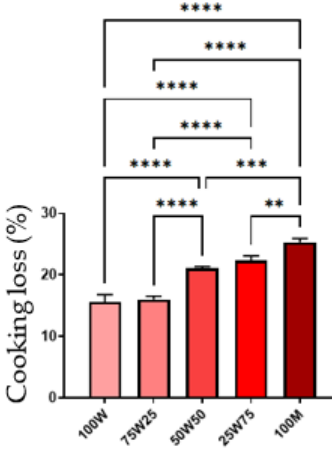
Figure 2. Cooking loss of batter-coated shrimp with MPBP. 100W: 100% wheat flour, 75W25: 75% wheat flour and 25% MPBP, 50W50: 50% wheat flour and 50% MPBP, 25W75: 25% wheat flour and 75% MPBP, 100M: 100. The error bars indicate standard division. ** p < 0.005, *** p < 0.0005, **** p < 0.00005.